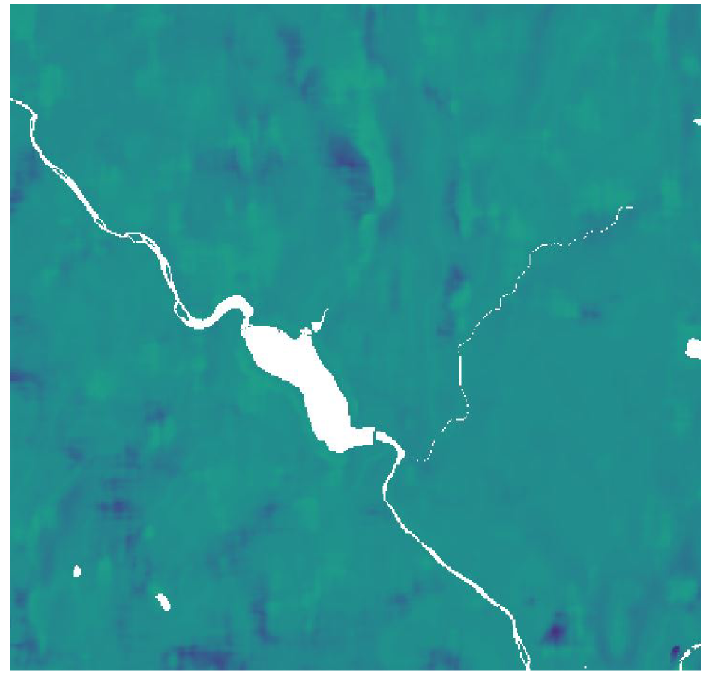
Figure 5. Soil moisture concentration satellite map around